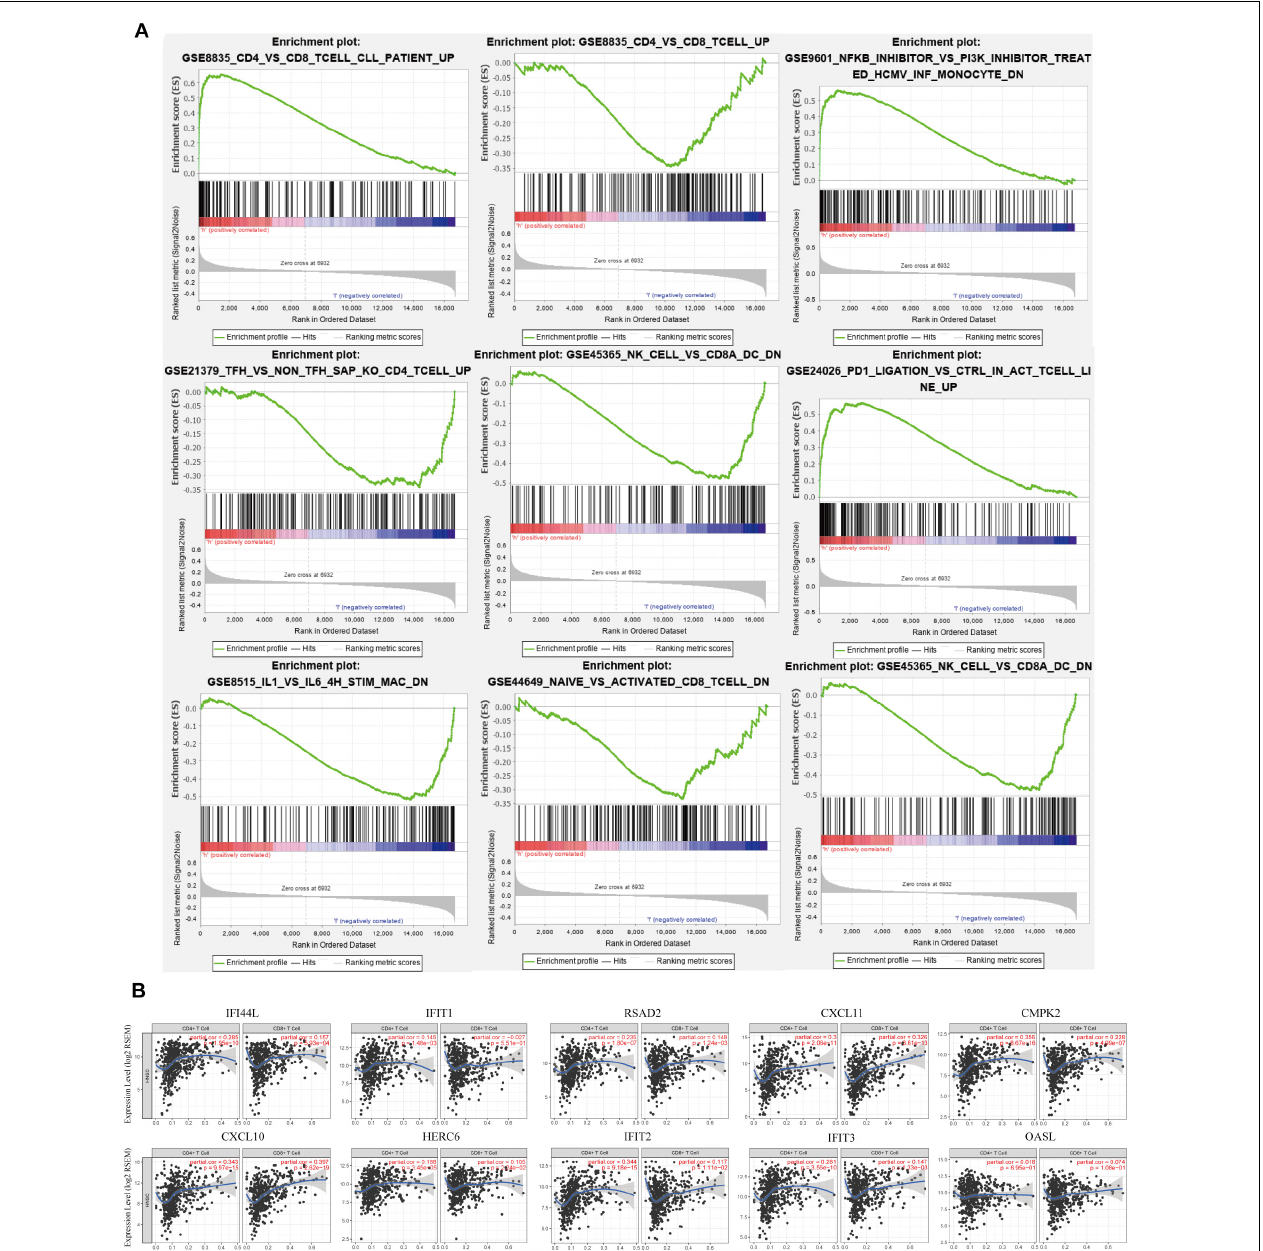
FIGURE 4 | Gene set enrichment analysis (GSEA) of The Cancer Genome Atlas (TCGA) head and neck squamous cell carcinoma (HNSC) immune signature gene sets. (A) GSEA results enriched in IFI44-high expression group vs. IFI44-low expression group (http://software.broadinstitute.org/gsea/downloads.jsp). (B) The correlation between enriched immune genes (Top 10 enriched genes from GSE8835) with CD4 + cell vs. CD8 cell using Tumor Immune Estimation Resource (TIMER) database.